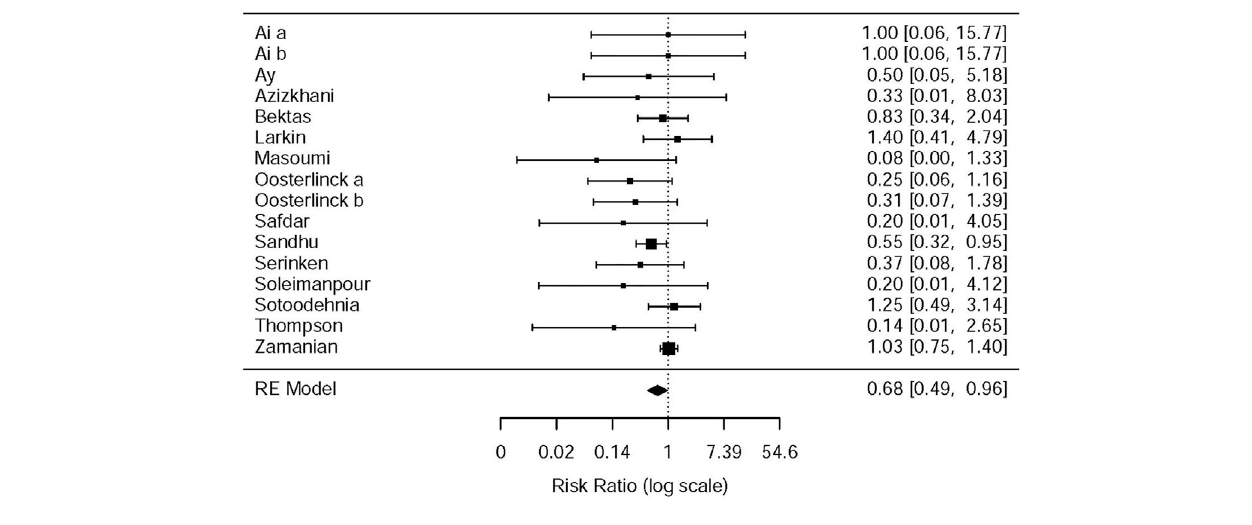
FIGURE 8 | The results of meta-analysis for vomiting caused by the medications.